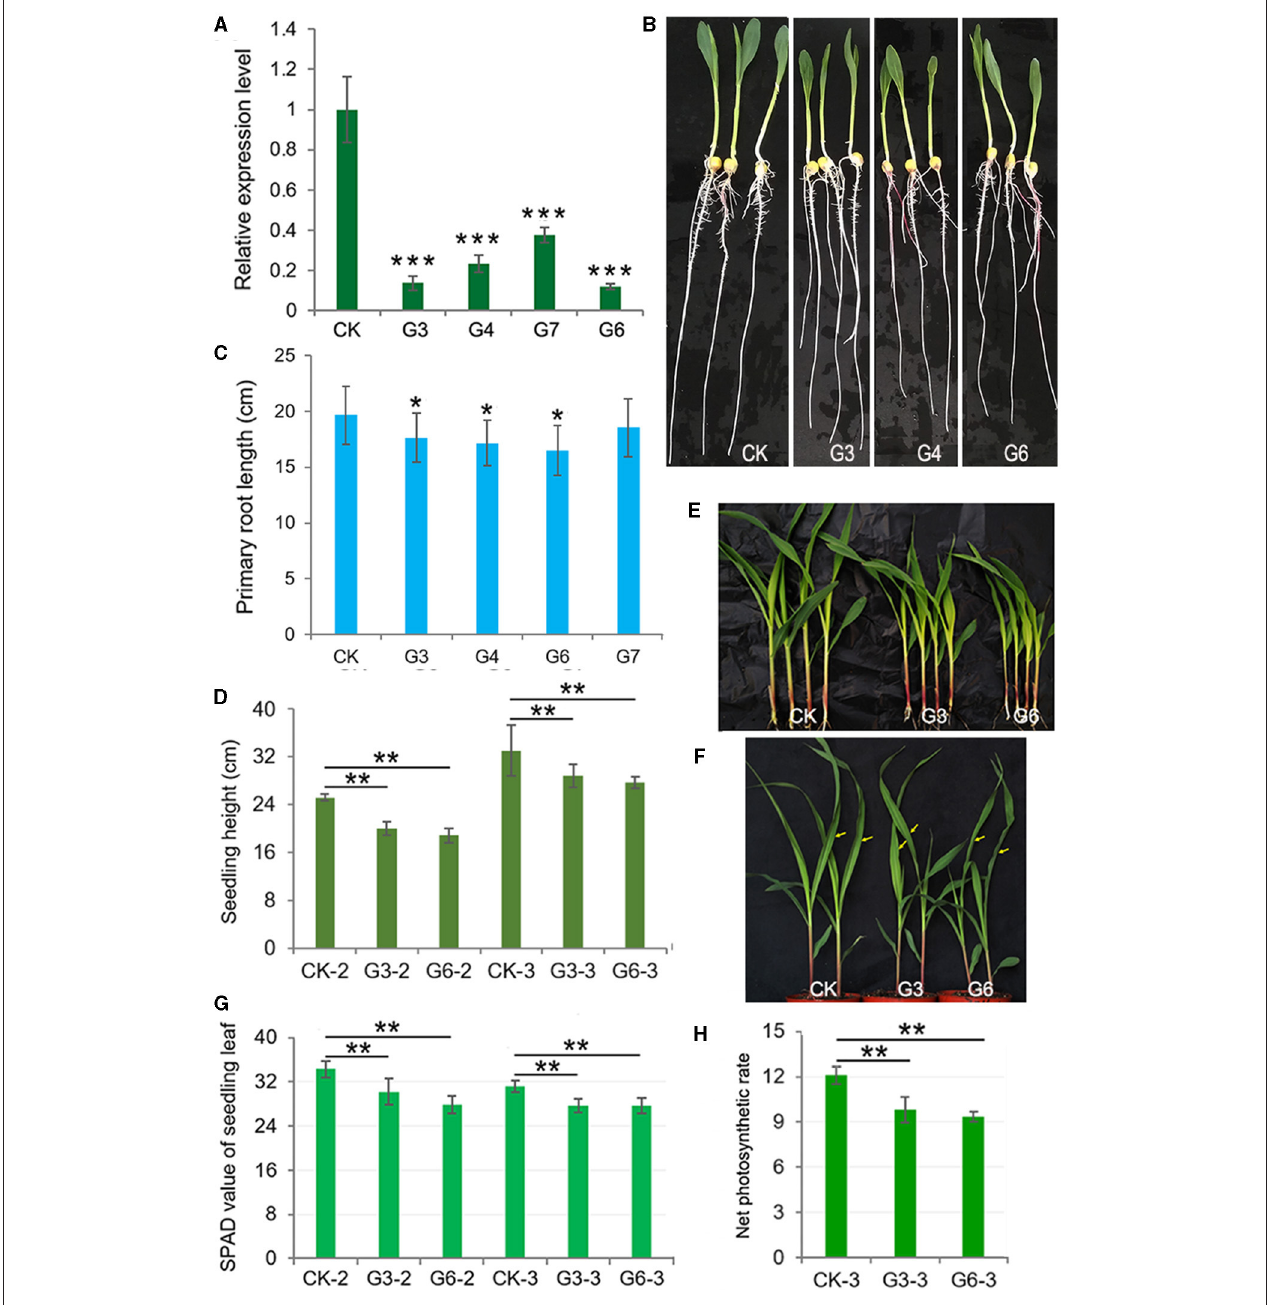
FIGURE 2 | (A) significantly decrease in ZmGT-3b expression suppresses the growth of maize seedlings owing to reduced photosynthetic rates and chlorophyll contents. (A) ZmGT-3b expression in the primary roots of transgenic maize seedlings is significantly reduced, compared with CK (the maize inbred line LH244, wild type) at 7 days after germination (DAG), with a pair of primers spanning the second and the third exon ( Supplementary Table 2 ) to detect the transcript level of the full complementary DNA (cDNA) of ZmGT-3b . G3, G4, G6, and G7 represent maize seedlings from four transgenic events, which were transformed with the partial coding sequence of the C-terminal of ZmGT-3b. Seedling phenotypes (B) and average primary root lengths (C) of 7 DAG maize seedlings ( n > 15). The average seedling height [ (D) , n > 15] and shoot phenotype [ (E) for 12 DAG and (F) for 15 DAG] of soil-cultured maize seedlings were grown in a greenhouse under natural light. Values are the mean ± SD ( n > 15). Twelve DAG seedlings with two leaves and a heart leaf are denoted as CK-2, G3-2, and G6-2, and 15 DAG seedlings with three leaves and a heart leaf are denoted as CK-3, G3-3, and G6-3 [used to measure the net photosynthetic rate (Pn)]. The SPAD values (G) of the above seedlings were obtained from the central widest part of the newest expanded leaf, that is, the second leaf of 12 DAG seedlings or the third leaf of 15 DAG seedlings. (H) The Pn ( µ mol CO 2 · m − 2 s − 1 ) of the central widest part of the third leaf of 15 DAG seedlings [indicated by an arrow in (F) ] was measured from 09:00 to 12:00 under natural light in a greenhouse. Error bars denote the mean ± SD of the biological replicates. The asterisk * indicates a statistically significant difference between CK and the GT-KD lines, as calculated by the paired Student’s t -test (* p < 0.05, ** p < 0.01, *** p <